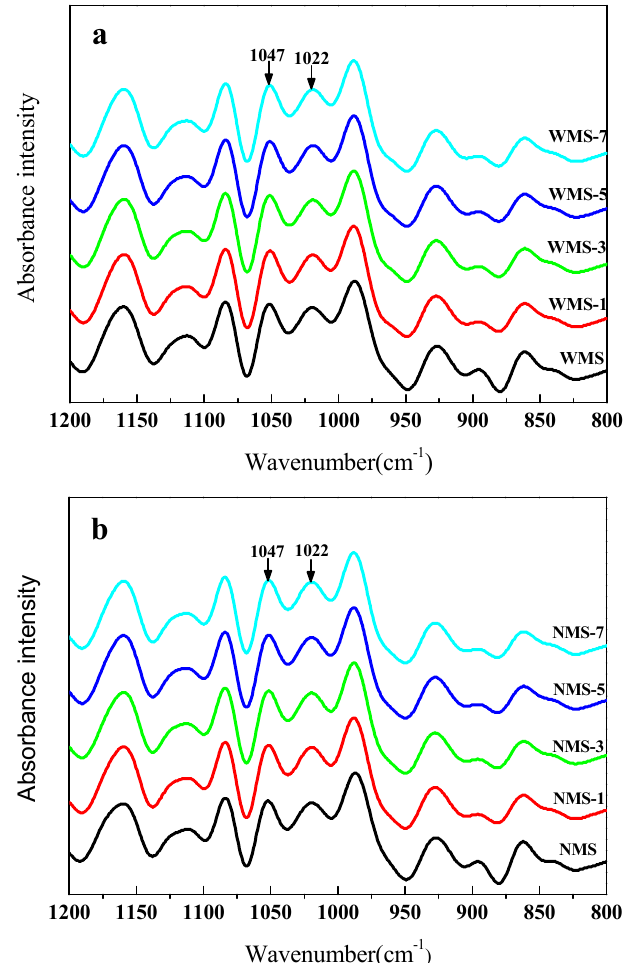
Figure 5. Deconvoluted FTIR spectra of maize starches from 1200–800 cm − 1 . ( a ) Waxy maize starch ( b ), normal maize starch.